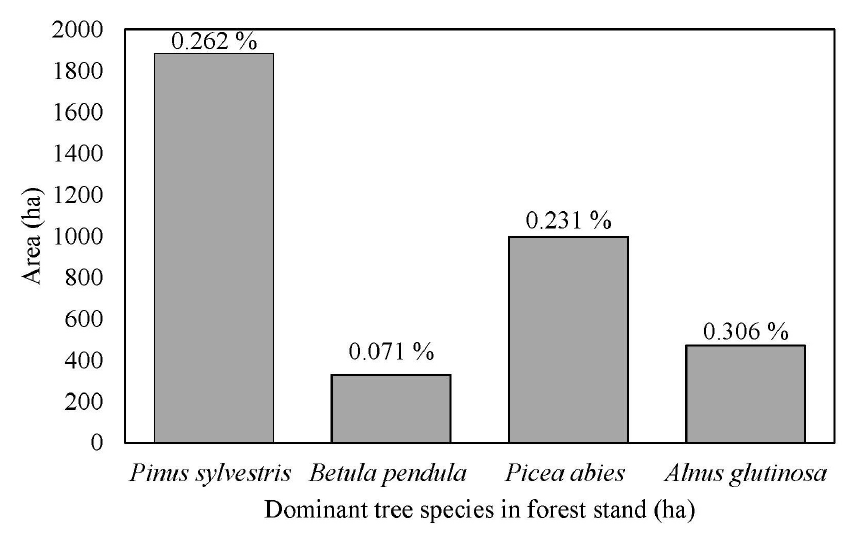
Figure 2. The distribution of Sambucus sp. in different Lithuanian forests stands (ha) and proportion of total dominated tree stands, in